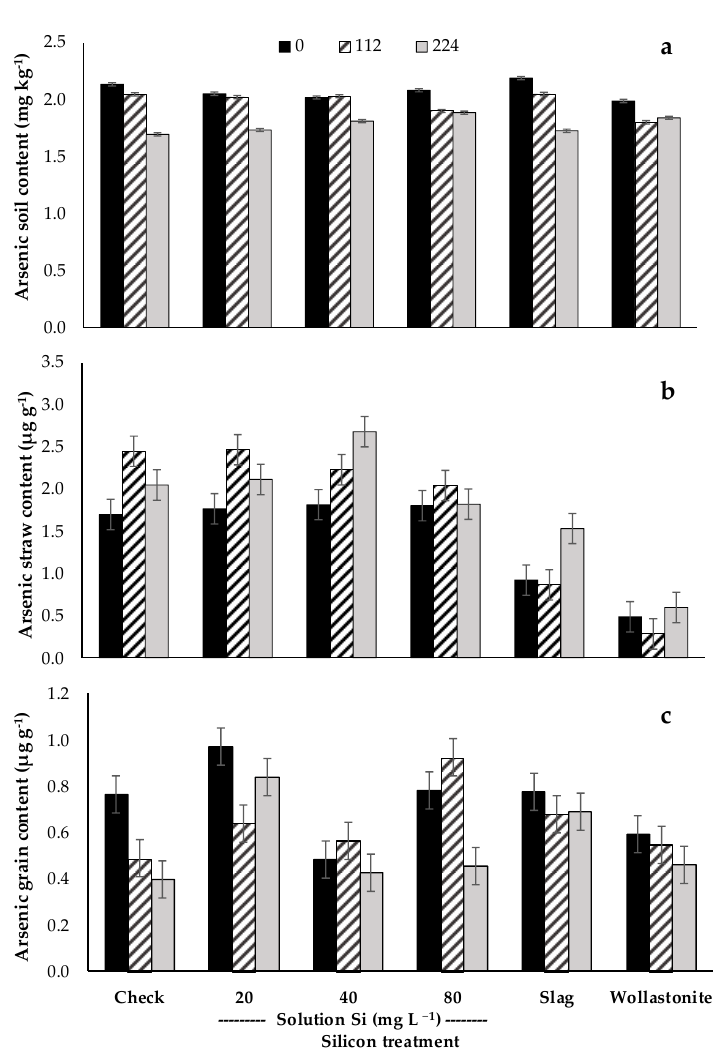
Figure 5. Effect of silicon treatments across phosphorus rates on arsenic content of soil ( a ), straw ( b ), and grain ( c ). Slag and wollastonite rates: 690 and 1190 kg Si ha − 1 , respectively.